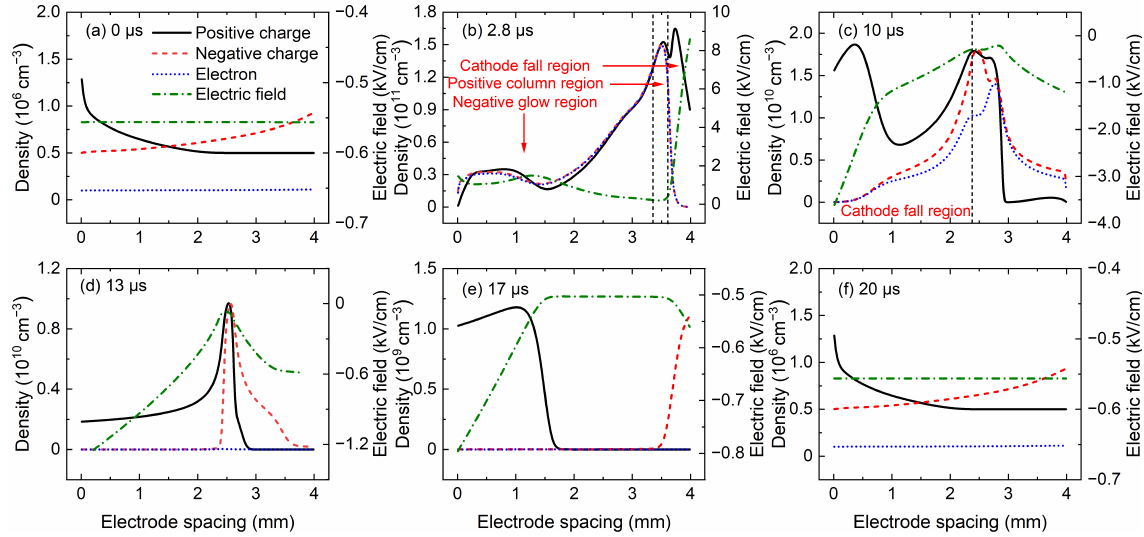
Figure 5. Spatial distributions of positive charge density, negative charge density, electron density, and electric field at several key moments in P1